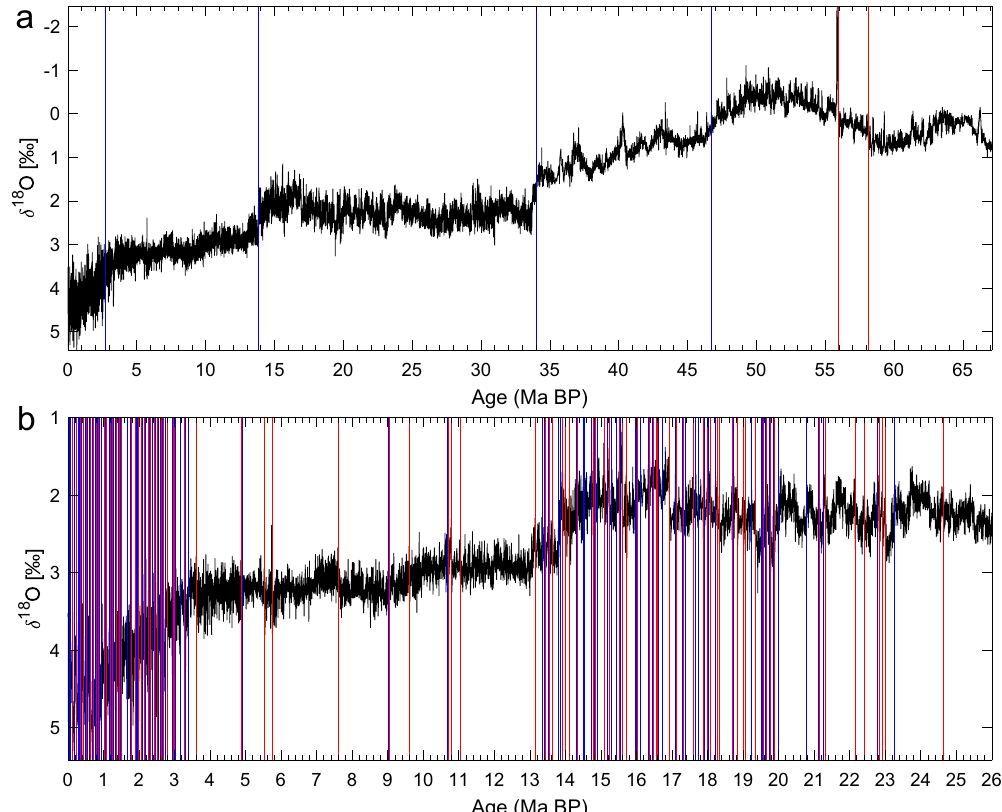
18 Figure 4. CENOGRID stack of benthic δ O 23 . Vertical lines represent transitions detected by the KS test 19 , with colors indicating the direction of the jumps. Grey bars represent warm episodes. ( a ) Transitions detected for the entire record using a window w range of 1–4 Myr, and ( b ) transitions detected for the interval 26–0 Ma BP using a w range of 0.02–2.5 Myr; see also the earlier subsection on “Methodology.” The vertical axes are reversed.